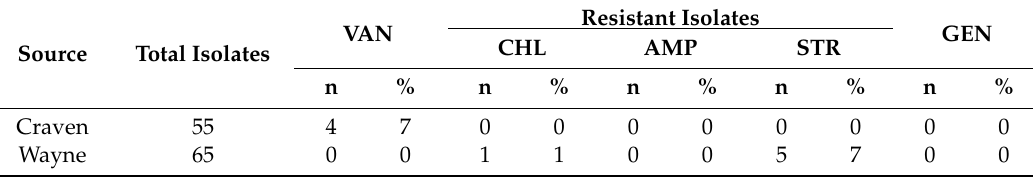
Table 4. Antimicrobial resistance in Enterococcus isolates from surface